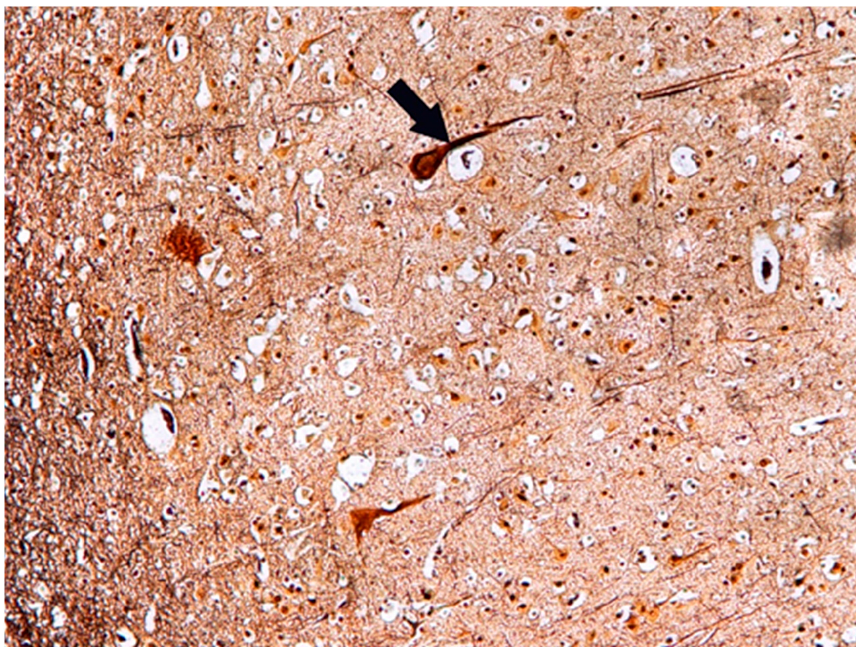
Figure 5. Case no. 8. Frontal lobe of the cortex. Visible neurofibrillary degeneration by silver impregnation with Modified Bielschowsky’s (arrow) stain. Neuronal shrinkage, angularity of cytoplasm and pyknotic nucleus. Magnification 400×.